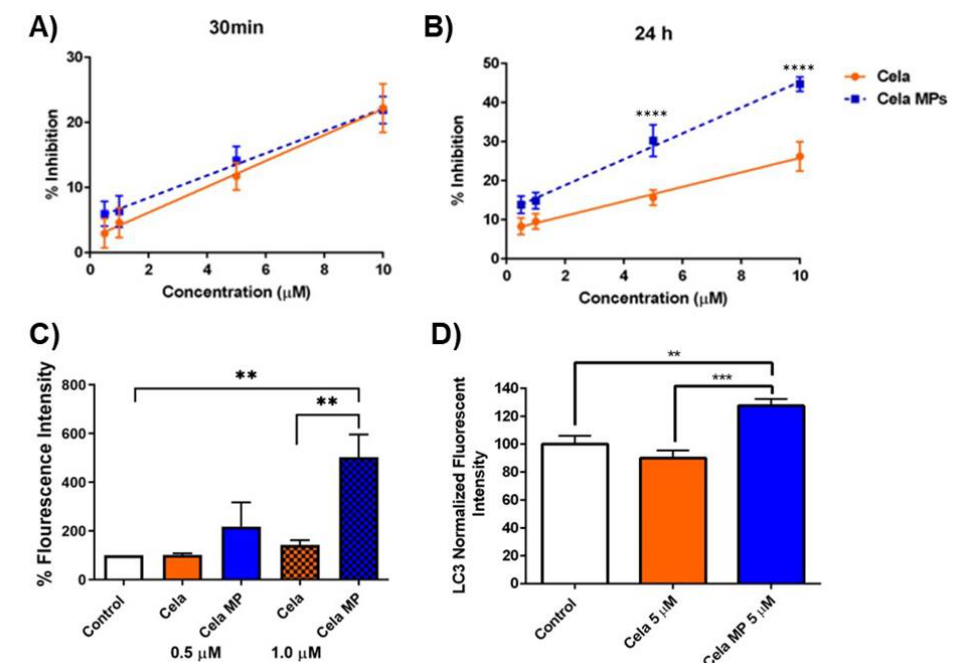
Figure 6. Maintenance of antioxidant properties of Cela MPs and activation of apoptosis and autophagy pathways. ( A ). & ( B ). DPPH radical scavenging activity of different concentrations of Cela MPs (0.5–10 µ M) when compared with Cela measured and calculated at 30 min ( A ) and 24 h ( B ). Data represent mean ± SD (n = 3). Significance between the groups was analyzed by multiple t-test analyses. Data represent mean ± SD (n = 3). ( C ). Quantification of caspase-3 as percent fluorescence intensity of Cela and Cela MP treatments as compared to control on MSTO-211H cells after 6 h treatment. Data represent mean ± SEM (n = 3). ( D ). Representation of autophagy induction on MSTO-211H cells by measuring LC3B protein fluorescence intensity (normalized). Data represent mean ± SD (n = 3). ** p < 0.01, *** p < 0.001, and **** p < 0.0001 .